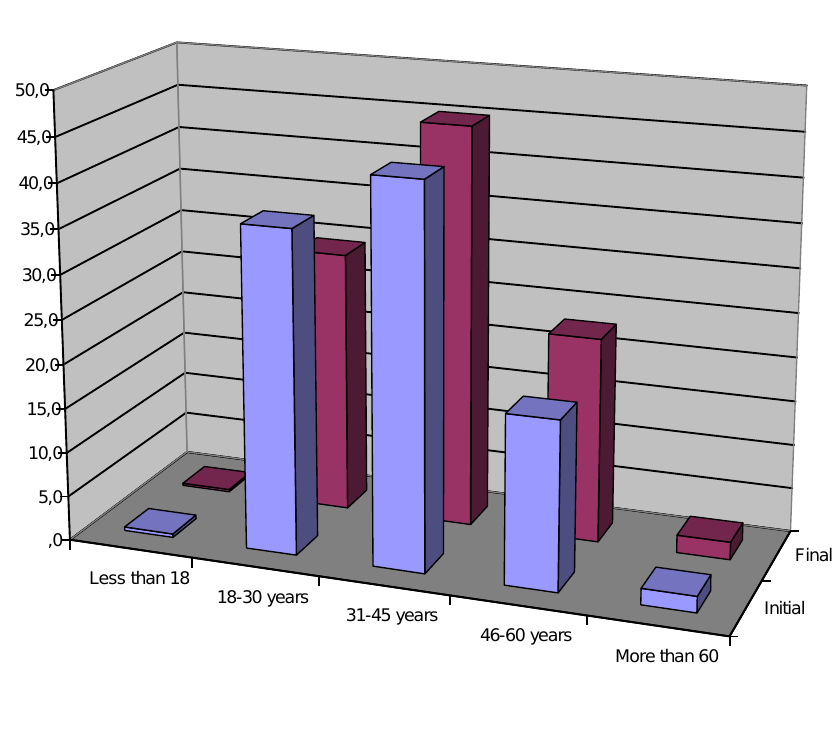
Figure 2. Distribution of respondents by age group and initial/final survey. By nationality, almost four out of five of those responding to the initial questionnaire reside in Spain (79.5%). When referred to the general MOOC offer in the world, Oliver, Hernández-Leo, Daza, Martín, and Albó (2014), explain how “from the demand side, Spain also stands within the top-five countries with more participants, right after USA, UK, Canada and Brazil” (p.